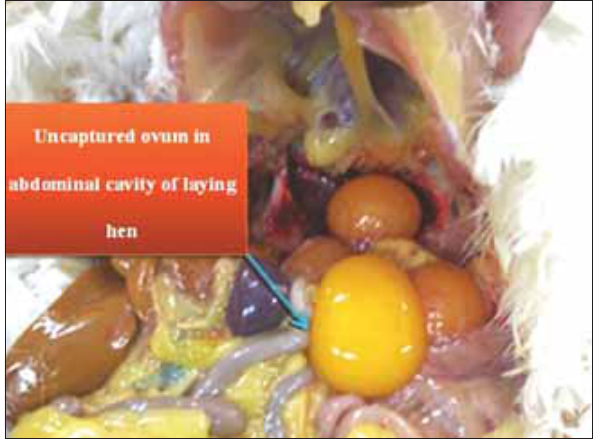
Figure-1: Uncaptured ovum in the abdominal cavity of broiler breeder hens (Internal